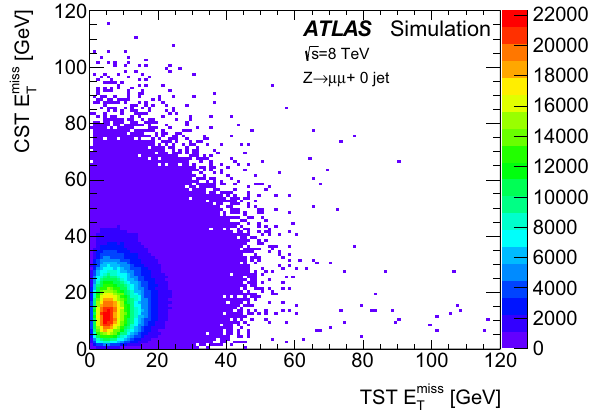
Fig. 17 The CST E miss versus the TST E miss in Z → μμ + 0-jet T T events from the MC simulation. The vector correlation coefficient is 0.177